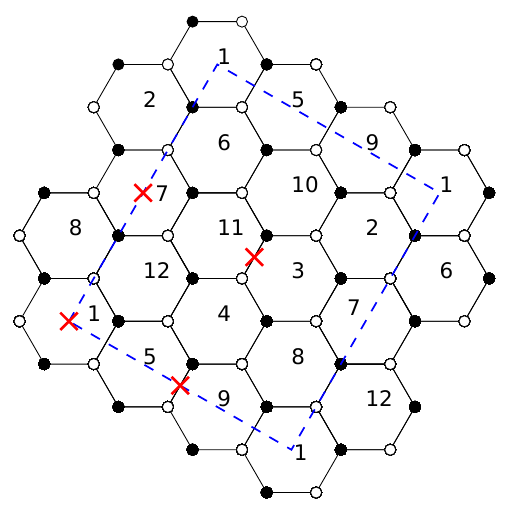
dimer with orientifold 12